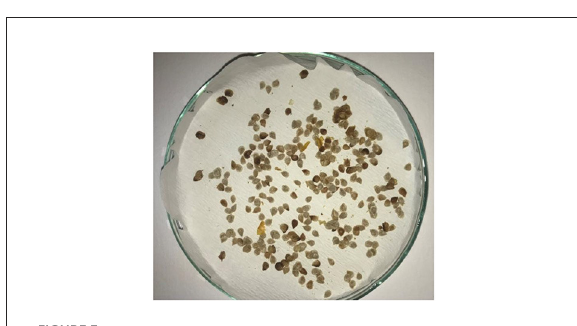
FIGURE3 Color changes and signs of wrinkling observed in tomato